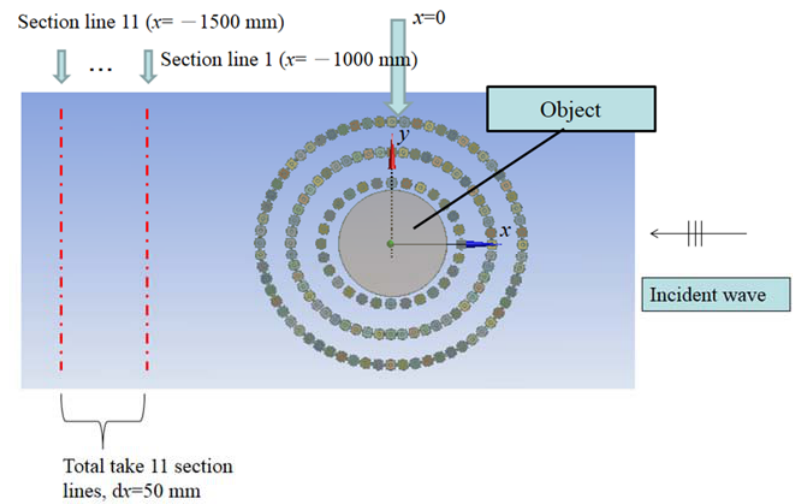
Figure 16. Position of section lines in acoustic scattering field. To determine peak pressure field values, the section path lines were set between x = − 1000 mm and x = − 1500 mm.